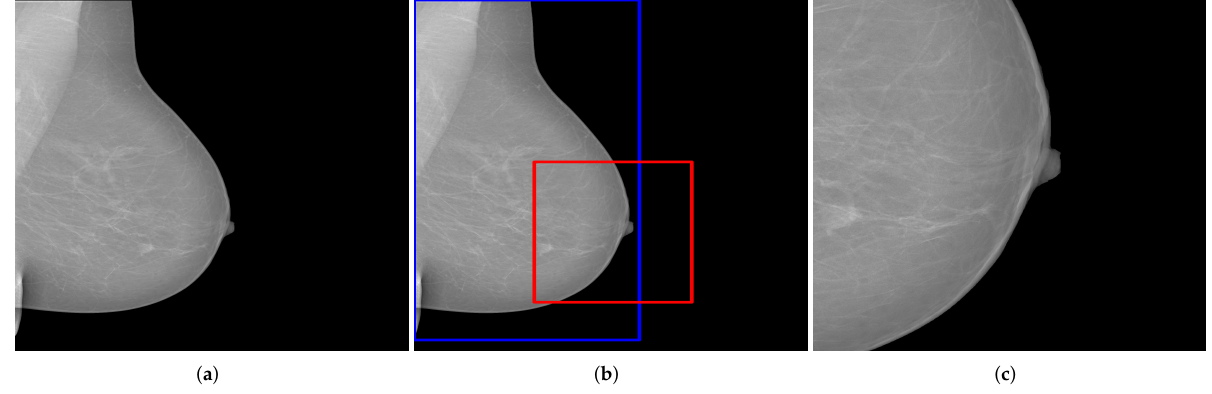
Figure 14. Example of a generated mammogram showing the nipple in a relatively enlarged area. The blue bounding box represents the identified breast area and the red box represents the cut-off area. ( a ) original mammogram; ( b ) identifying the breast and the cut-off-area; ( c ) resulting mammogram using the crop